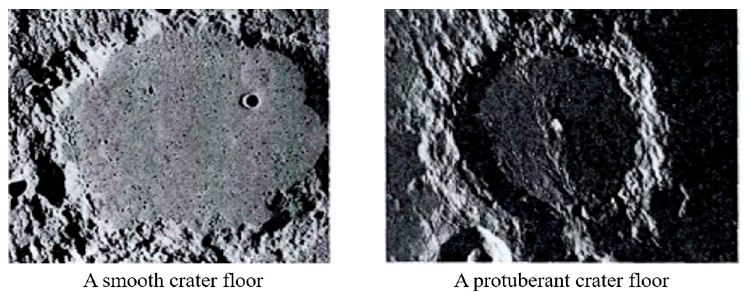
Figure 8. Crater floor shapes (from NASA, [52]).